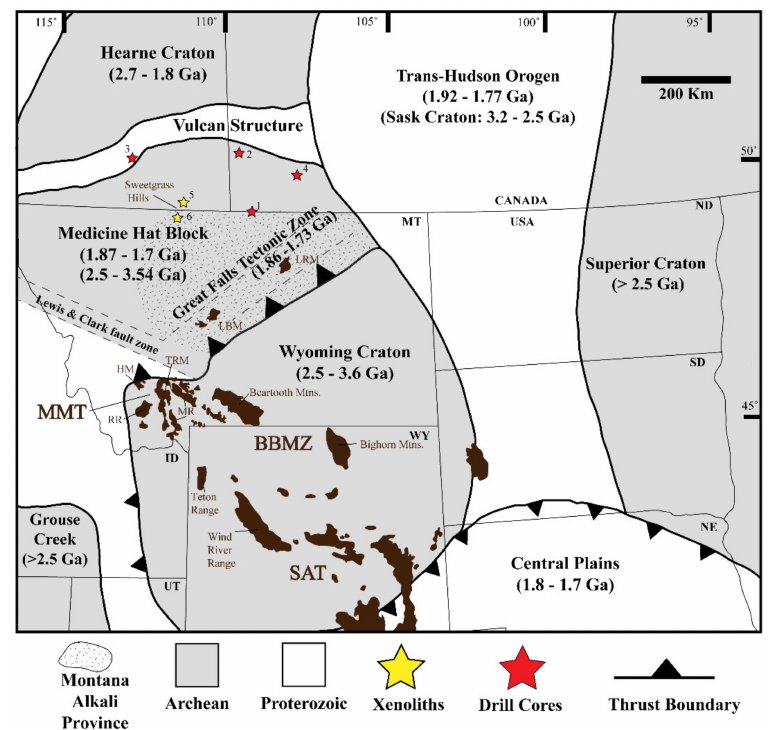
Figure 1. Generalized map of Precambrian basement provinces of southwestern Laurentia with the Montana alkali province (MAP) shown without a solid boundary, as the extent of the MAP is not well known (after [2,15–19]). MMT: Montana Metasedimentary Terrane; BBMZ: Bighorn-Beartooth Magmatic Zone. TRM: Tobacco Root Mountains; HM: Highland Mountains; RR: Ruby Range; MR: Madison Range; LRM: Little Rocky Mountains; LBM: Little Belt Mountains. Drill core